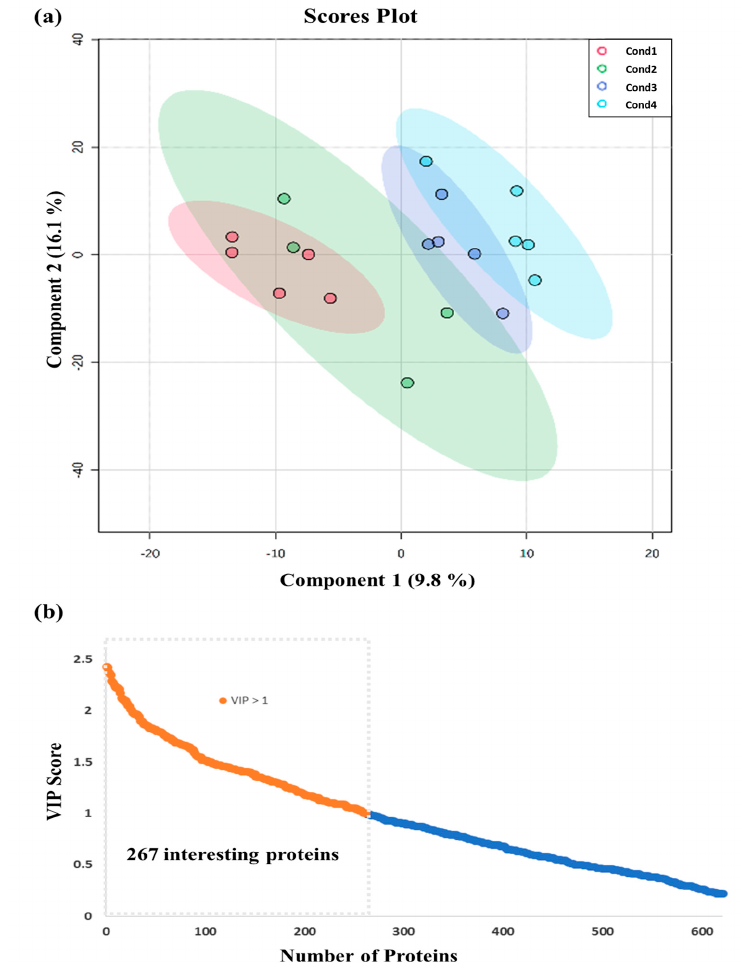
Figure 1. PLS-DA multivariate analysis of the detected 858 proteins from embryonal masses induced under four di ff erent temperature treatments (Cond1: 23 °C; Cond2: 40 °C (4 h); Cond3: 50 °C (30 min); Cond4: 60 °C (5 min)): ( a ) bi-dimensional representation of the scores. Data normalization was performed using the AutoScale method, and the scores of the two fi rst components are represented, showing the ovals at 95% con fi dence interval; ( b ) variable importance in projection (VIP) scores. From the 858 quanti fi ed proteins, 267 were selected as interesting variables for the group separation observed in the scores plot. A cut-o ff of 1 was considered to select the important variables.